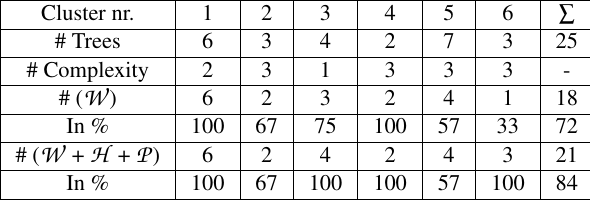
Table 1: Behavior for the modules W and H for six example clusters of trees. The second row shows number of trees in the group while the second row shows the complexity level of the situation (trees growing close to each other, under the crones of other trees etc.): Not very challenging (1), challenging (2), and very challenging (3). The lines 3-6 show the absolute and relative numbers of detected individual trees for the methods discussed above. Unfortunately, no ground truth was obtained for Fig.3, 10-13. Also, delineation of some single trees was not recorded. Cluster nr.